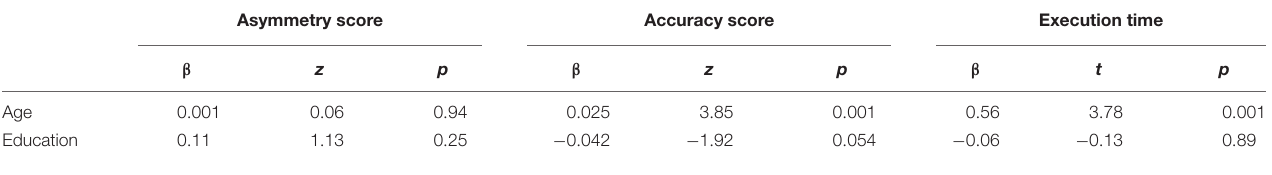
TABLE 3 | Summary of results for the three dependent variables of the Bells Test (asymmetry score, accuracy score and execution time) as a function of age and education. Asymmetry score Accuracy